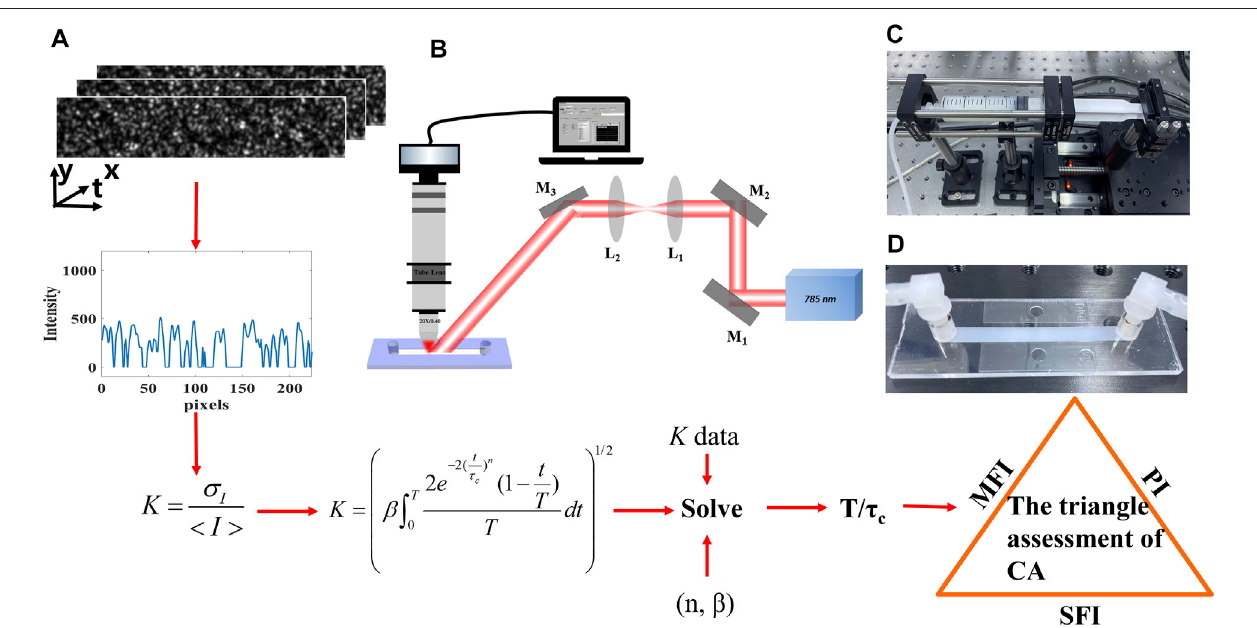
FIGURE1| Schematicoftheexperiment. (A) Flowchartofthemodelandderivationprocess. (B) Diagramoftheilluminatingandimagingsystem.M,mirror;L,lens. (C) Step motor. (D) Micro fl uidic device.